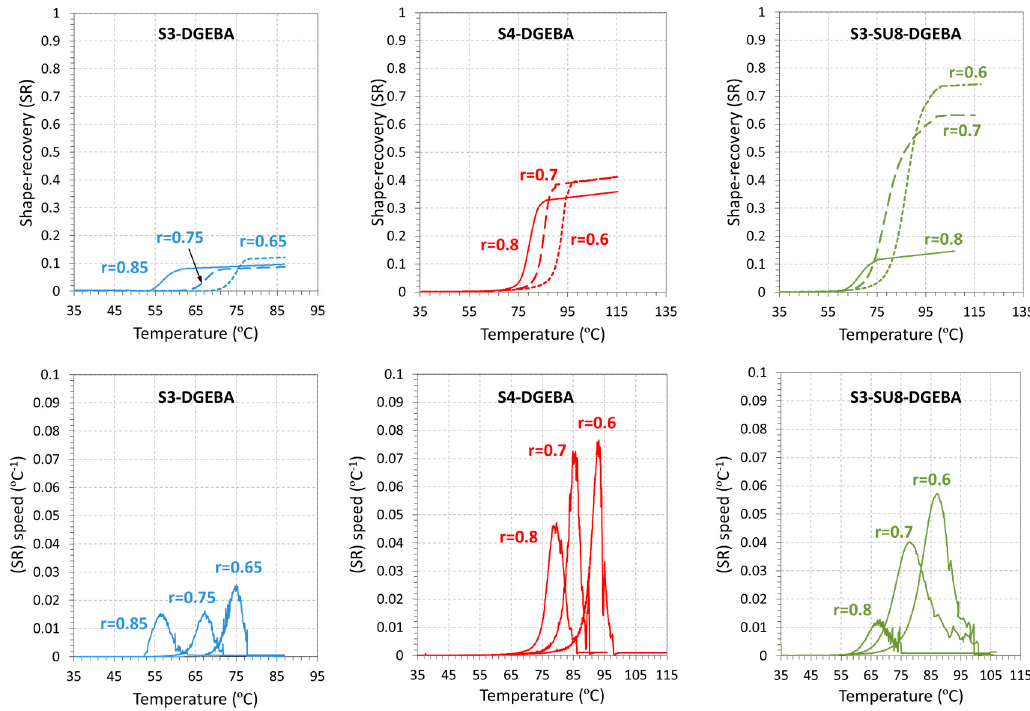
Figure 11. Shape-memory partially-constrained recovery experiments: shape-recovery as a function of the temperature.